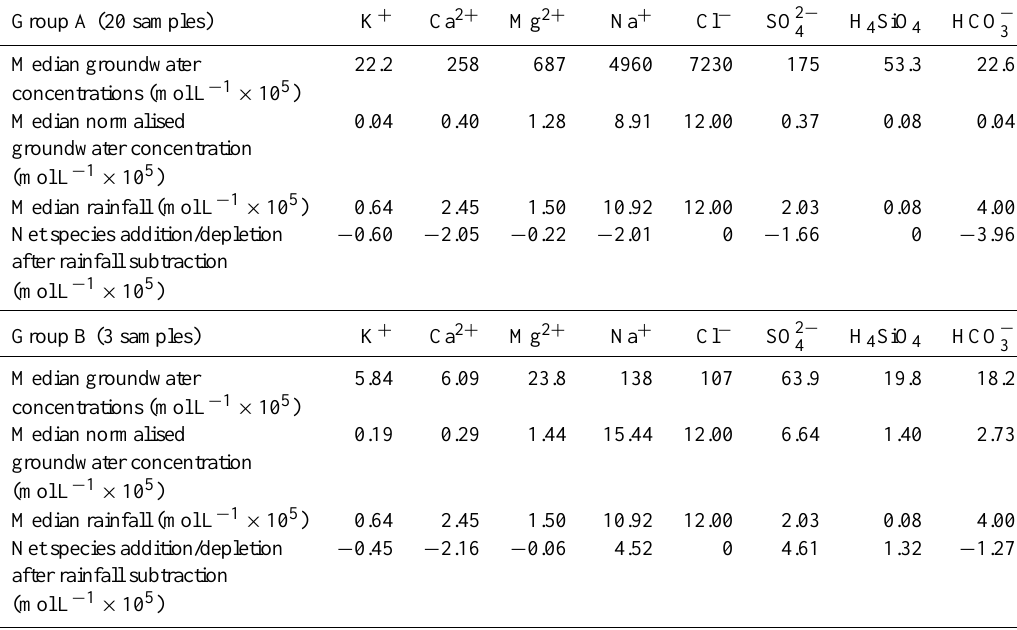
Table 5. Subtraction of rainfall input from groundwater composition.